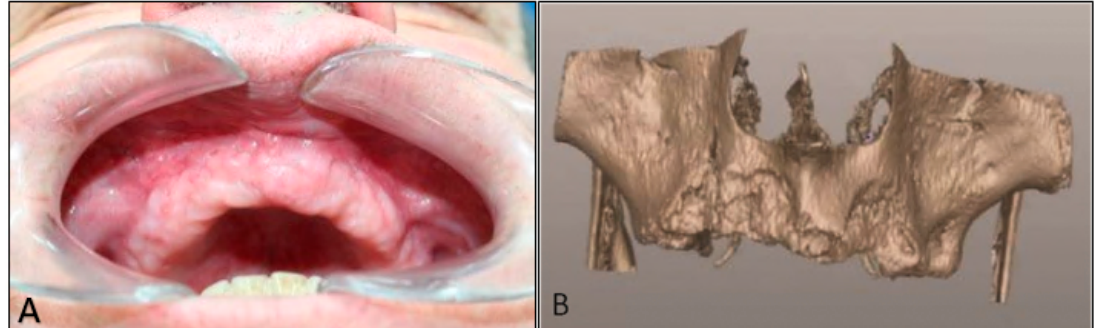
Figure 1. Initial situation of the pre-maxilla: ( A ) soft tissue of the edentulous area, ( B ) 3D CAD reconstruction of the upper jaw atrophy.